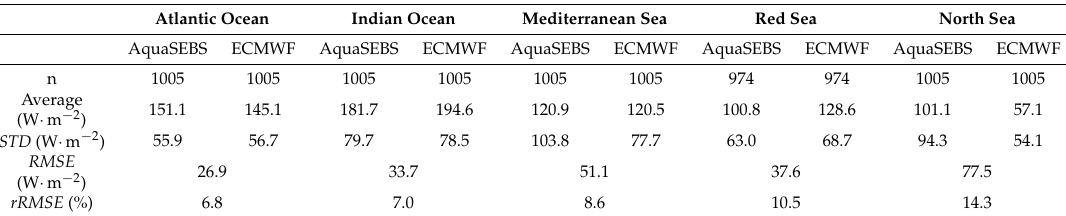
Table 7. Comparison of the latent heat values calculated by the AquaSEBS and ECMWF models (January 2010 to September 2012).